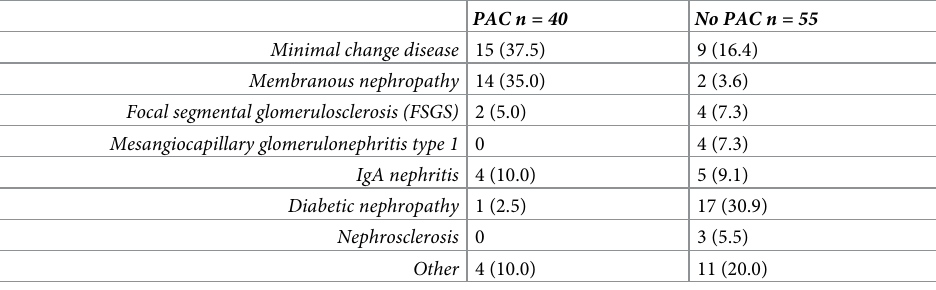
Table 2. Distribution of diagnoses from kidney